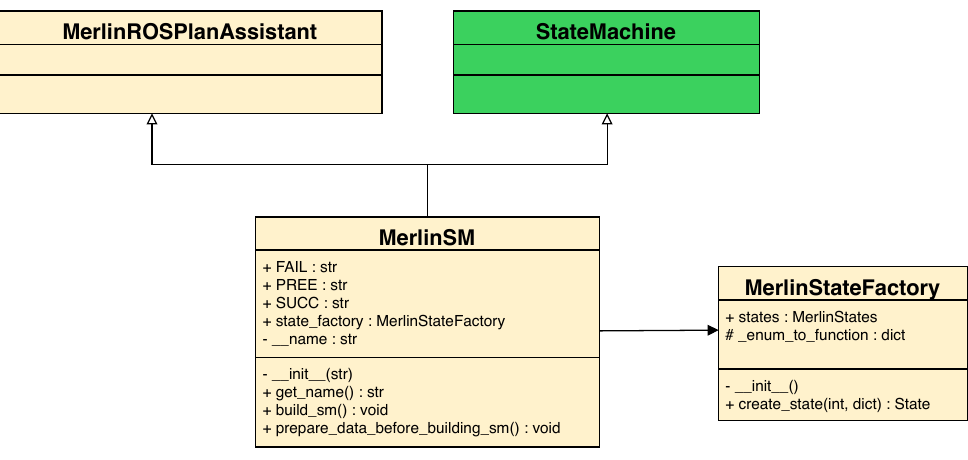
Figure 2. Class Diagram of MERLIN Finite-State